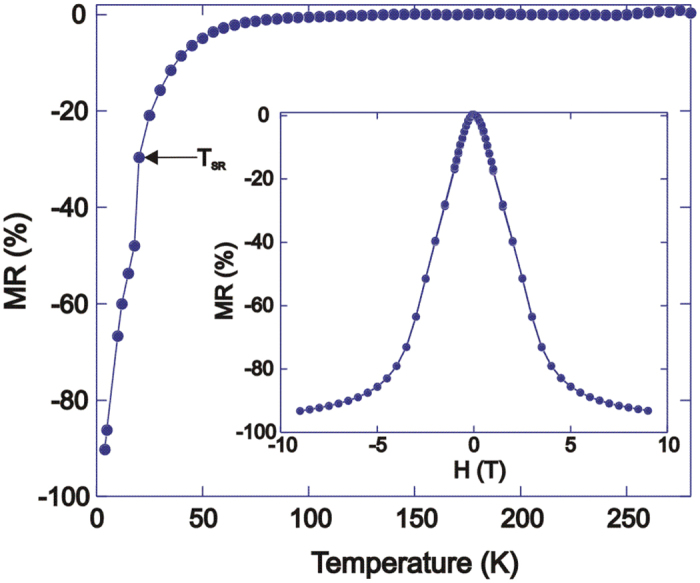
Magnetoresistance data as a function of temperature and field for NdMnAsO0.95F0.05.A MR of −90% at 4 K, 7 T is observed. The inset shows the variation of MR with field at 4 K.